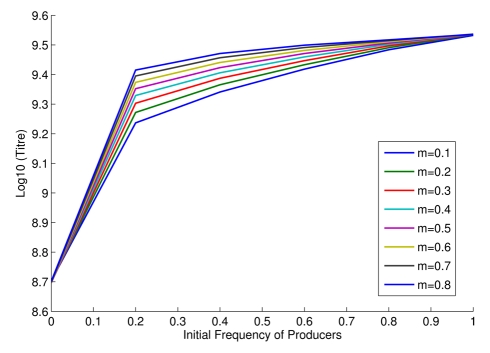
Theoretical expectations for titre when invertase production matches sucrose levels (perfect information).